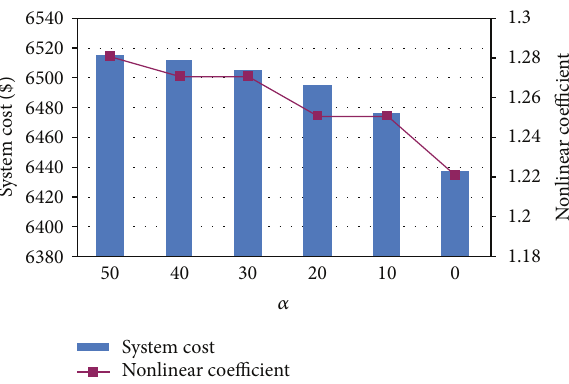
Figure 7: Relation between demand distribution and system cost or nonlinear